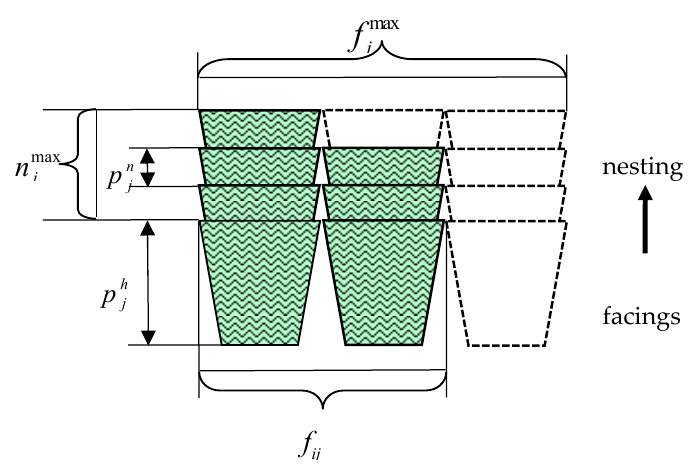
Figure 3. Allocation of caps.